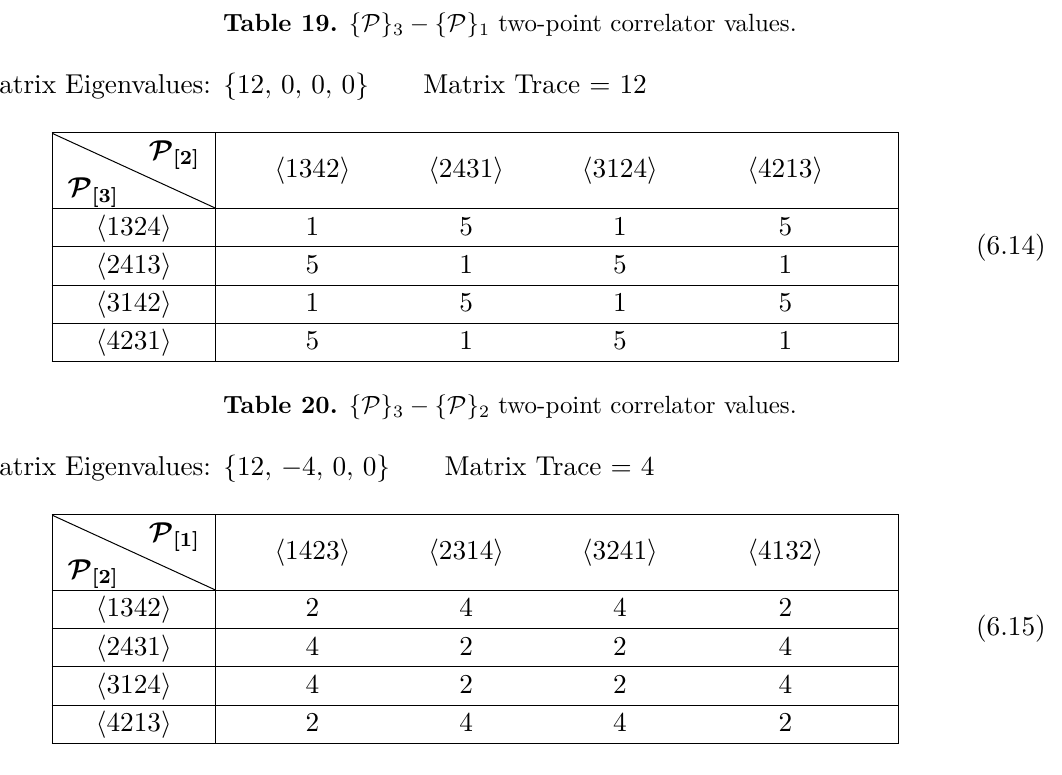
Table 21. {P} 2 − {P} 1 two-point correlator